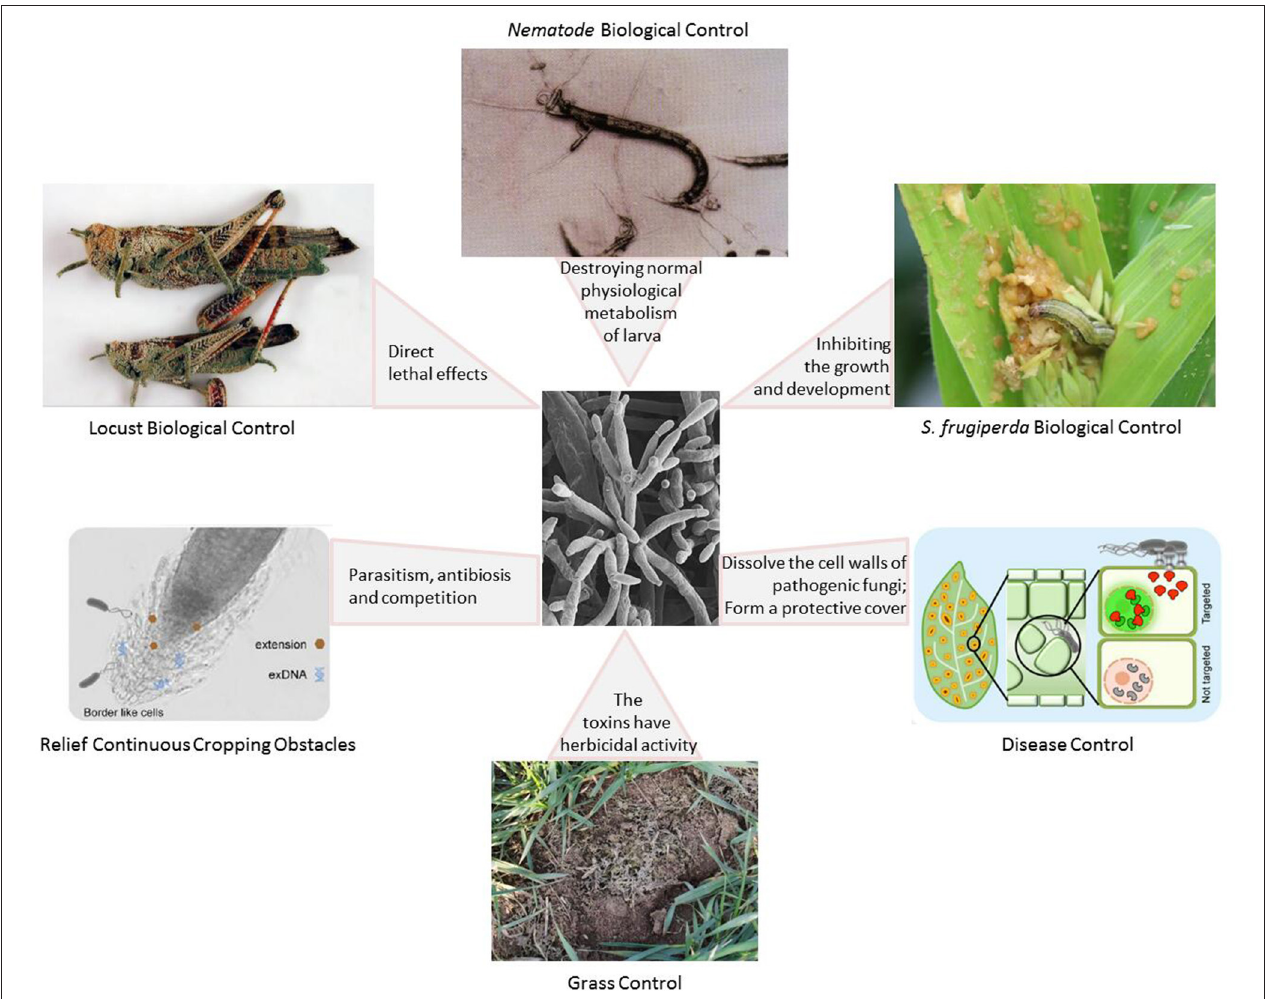
FIGURE 4 | The role of phytopathogenic fungi as a biological control agent with different mechanisms of action (Hamel et al., 2012; Pereira et al., 2014; Clancy et al., 2017; Garrigues et al., 2018; Filizola et al., 2019; Kaur et al., 2019; Moisan et al., 2019; Toju and Tanaka, 2019; Ying and Feng, 2019; Dejasikora et al., 2020 ).